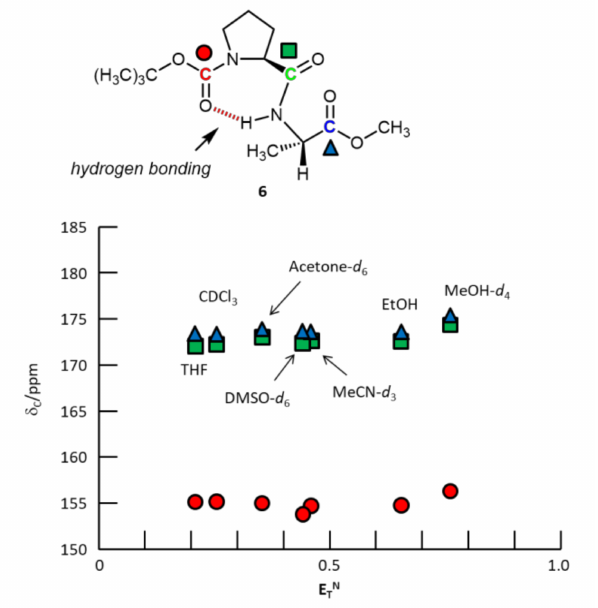
Figure 9. 13 C NMR chemical shifts of the carbonyl carbons of N -Boc-L-proline-L-alanine-OMe 6